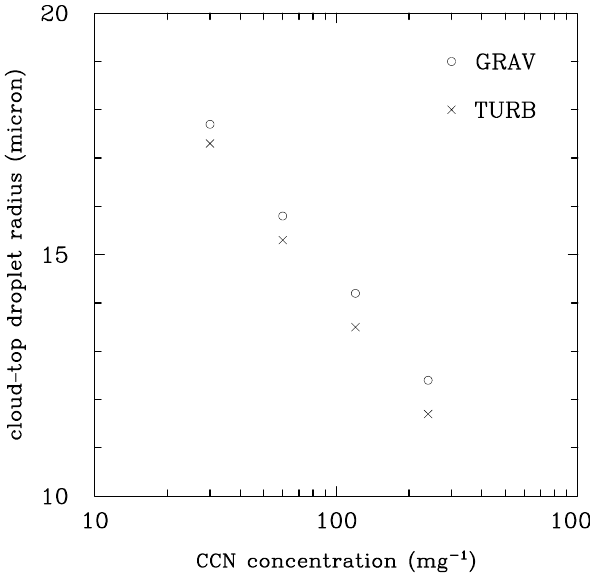
Figure 11. Cloud-top mean droplet radius for the − 15dBz radar reflectivity threshold as a function of the CCN concentration for GRAV and TURB